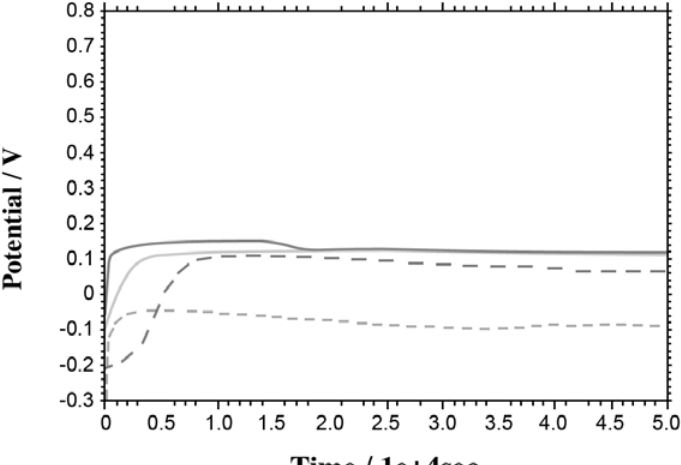
FIGURE 2- Open circuit potential (OCP) versus time curves of suprastructures (M1, M2, M3, M4) and Ti recorded in Afnor type solution at